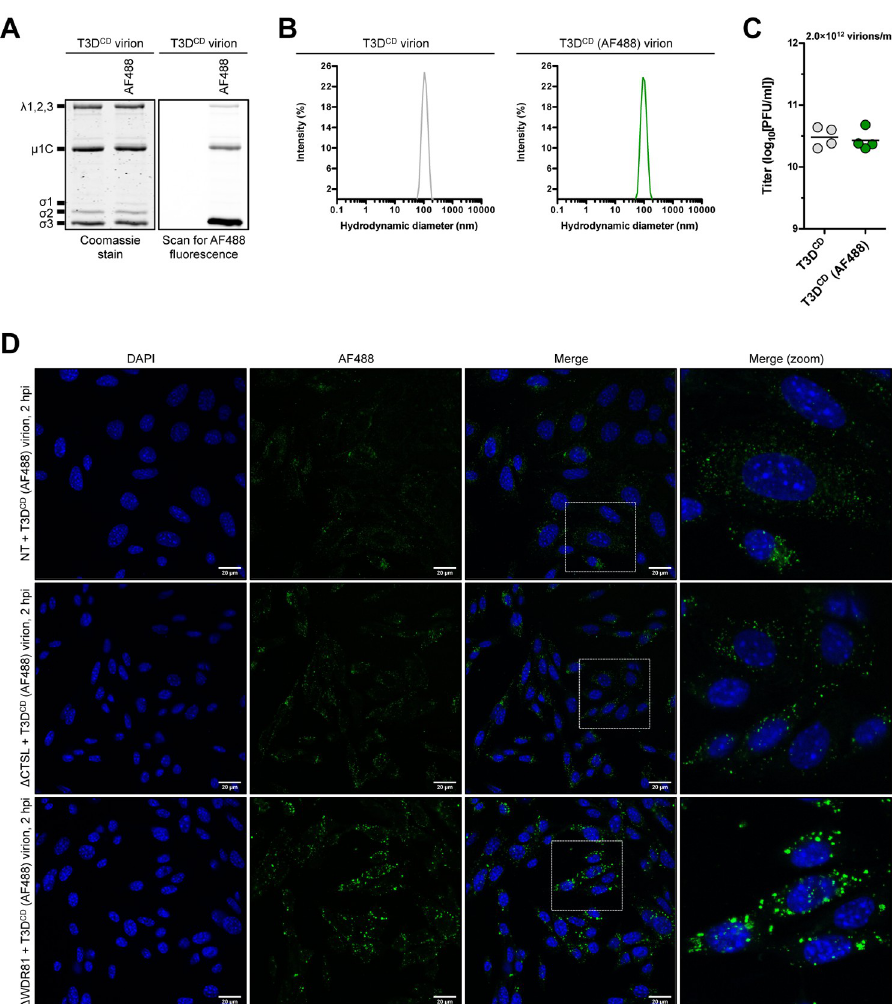
Fig 6. Infection of WDR81-deficient cells by T3D CD (AF488) virions. (A) Protein compositions. Unlabeled and AF488-labeled T3D CD virions were analyzed by SDS-PAGE. The gel was Coomassie brilliant blue stained (left side panel) and scanned for AF488 fluorescence (right side panel). The migration of capsid proteins is indicated on the left. μ 1 resolves as μ 1C [74] (n = 4 biological replicates; results for 1 representative experiment are shown). (B) Size distribution profiles. Unlabeled and AF488-labeled T3D CD virions were analyzed by dynamic light scattering (n = 4 biological replicates; results from 1 representative experiment are shown). (C) Specific infectivity. The titers of unlabeled and AF488-labeled T3D CD virions (2 × 10 12 particles/ml) were determined by plaque assay. Horizontal bars indicate the means (n = 4 biological replicates). (D) Localization within an infected cell. NT, Δ CTSL, and Δ WDR81 cells were infected with T3D CD (AF488) at 10,000 virions/cell. At 2 h post infection (hpi), the infected monolayers were fixed, stained with DAPI, mounted, and imaged by confocal microscopy. The images were obtained using a X63 oil- immersion objective and processed using ImageJ software [42]. The DAPI signal is false colored in blue, and the AF488 signal is false colored in green. The inset boxes in the ‘Merge’ column are expanded in the ‘Merge (zoom)’ column. The scale bars represent 20 μ m (n = 3 biological replicates; results from 1 representative experiment are shown).